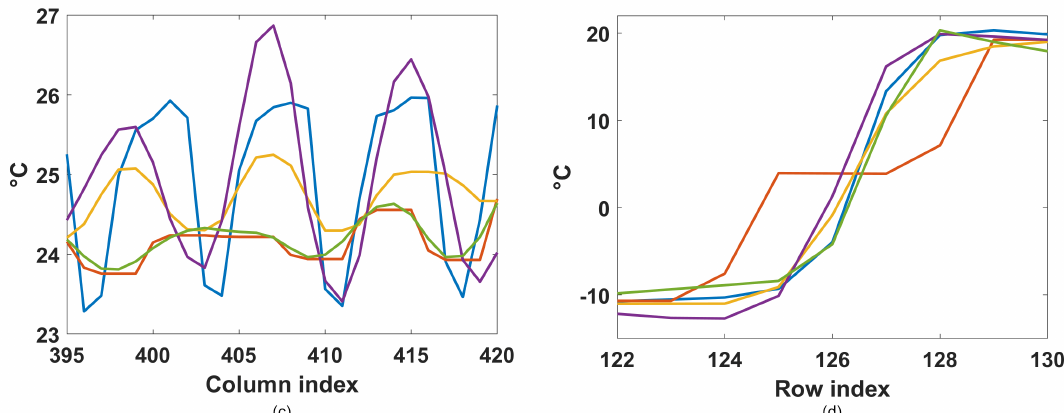
Figure 5. ( a , b ) Plot of the results obtained by different methods in the portion of rows highlighted by the dashed segments in the R1 and R2 ROIs of the I1 image of Figure 2a, respectively. ( c , d ) Plot of the results obtained by different methods in the portion of the row and column highlighted by the the dashed segments in the R1 and R2 ROIs of the I2 image of Figure 2b, respectively. In all the graphics, we compare the ground truth values (blue line) with the reconstructions obtained by the NN (red line), ASR2_m (yellow line), ARS2_s (purple line), and EDSR (green line) methods.